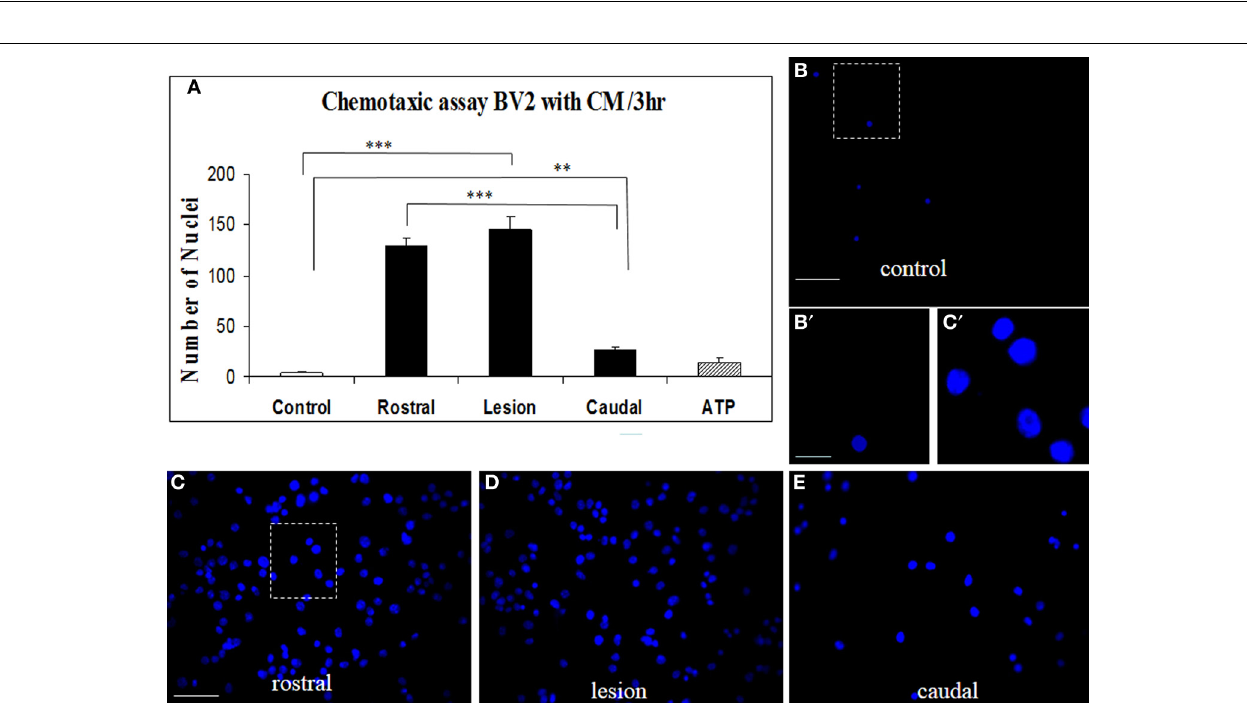
FIGURE 2 | CM SCI-induced BV2 cell chemotaxis in the transwell assay. ActivatedBV2cellswerequantifiedbycountingthenumberofHoechst-labeled cells attached to the Boyden membrane after incubation with CM from control spinal segment (A,B,B’) , with CM from rostral (A,C) , lesion (A,D) and caudal (A,E) segmentsafterSCIandATP (A) .Significantincreaseofattachedmicroglia